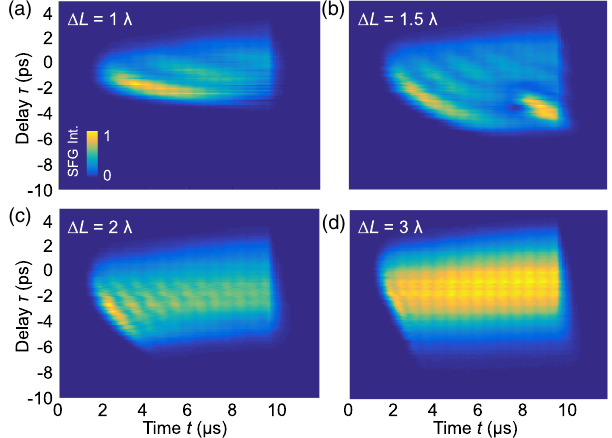
FIG. 6. Evolution of the micropulse shape I ð τ Þ within a macropulse of the FEL oscillator at different cavity detunings. The data for Δ L ¼ 1 λ − 3 λ are measured by SFG cross- correlation (linear scale of SFG intensity). Limit-cycle oscillations of the FEL power are clearly resolved in the cases of (a) –